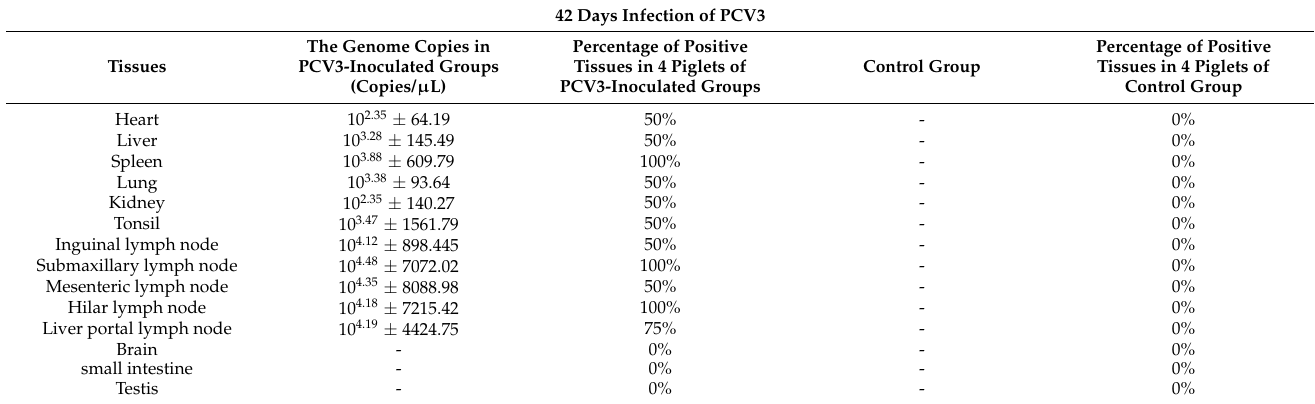
Table 4. Summary of PCV3 loads in the various by tissues qRT-PCR at 42 days infection.